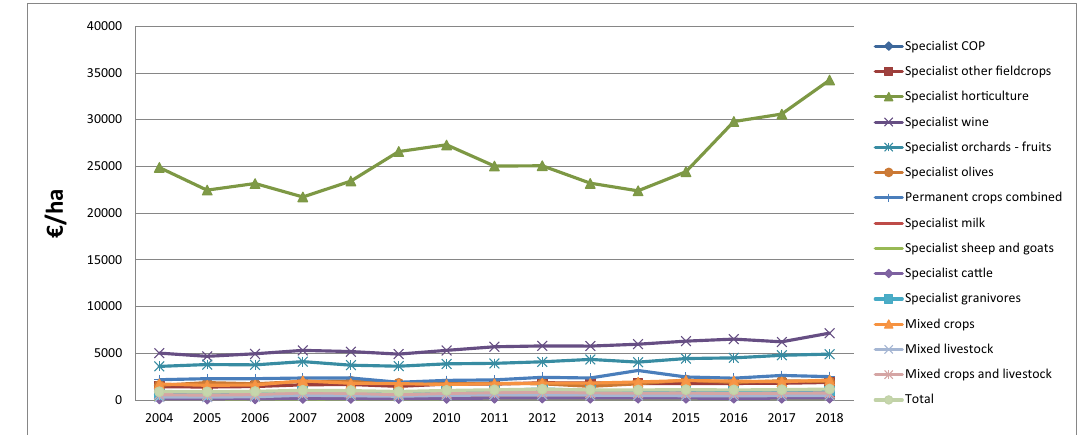
Figure 6: Total crops output ( € /ha ) , per farm, for the several farm types, for the period 2004 –